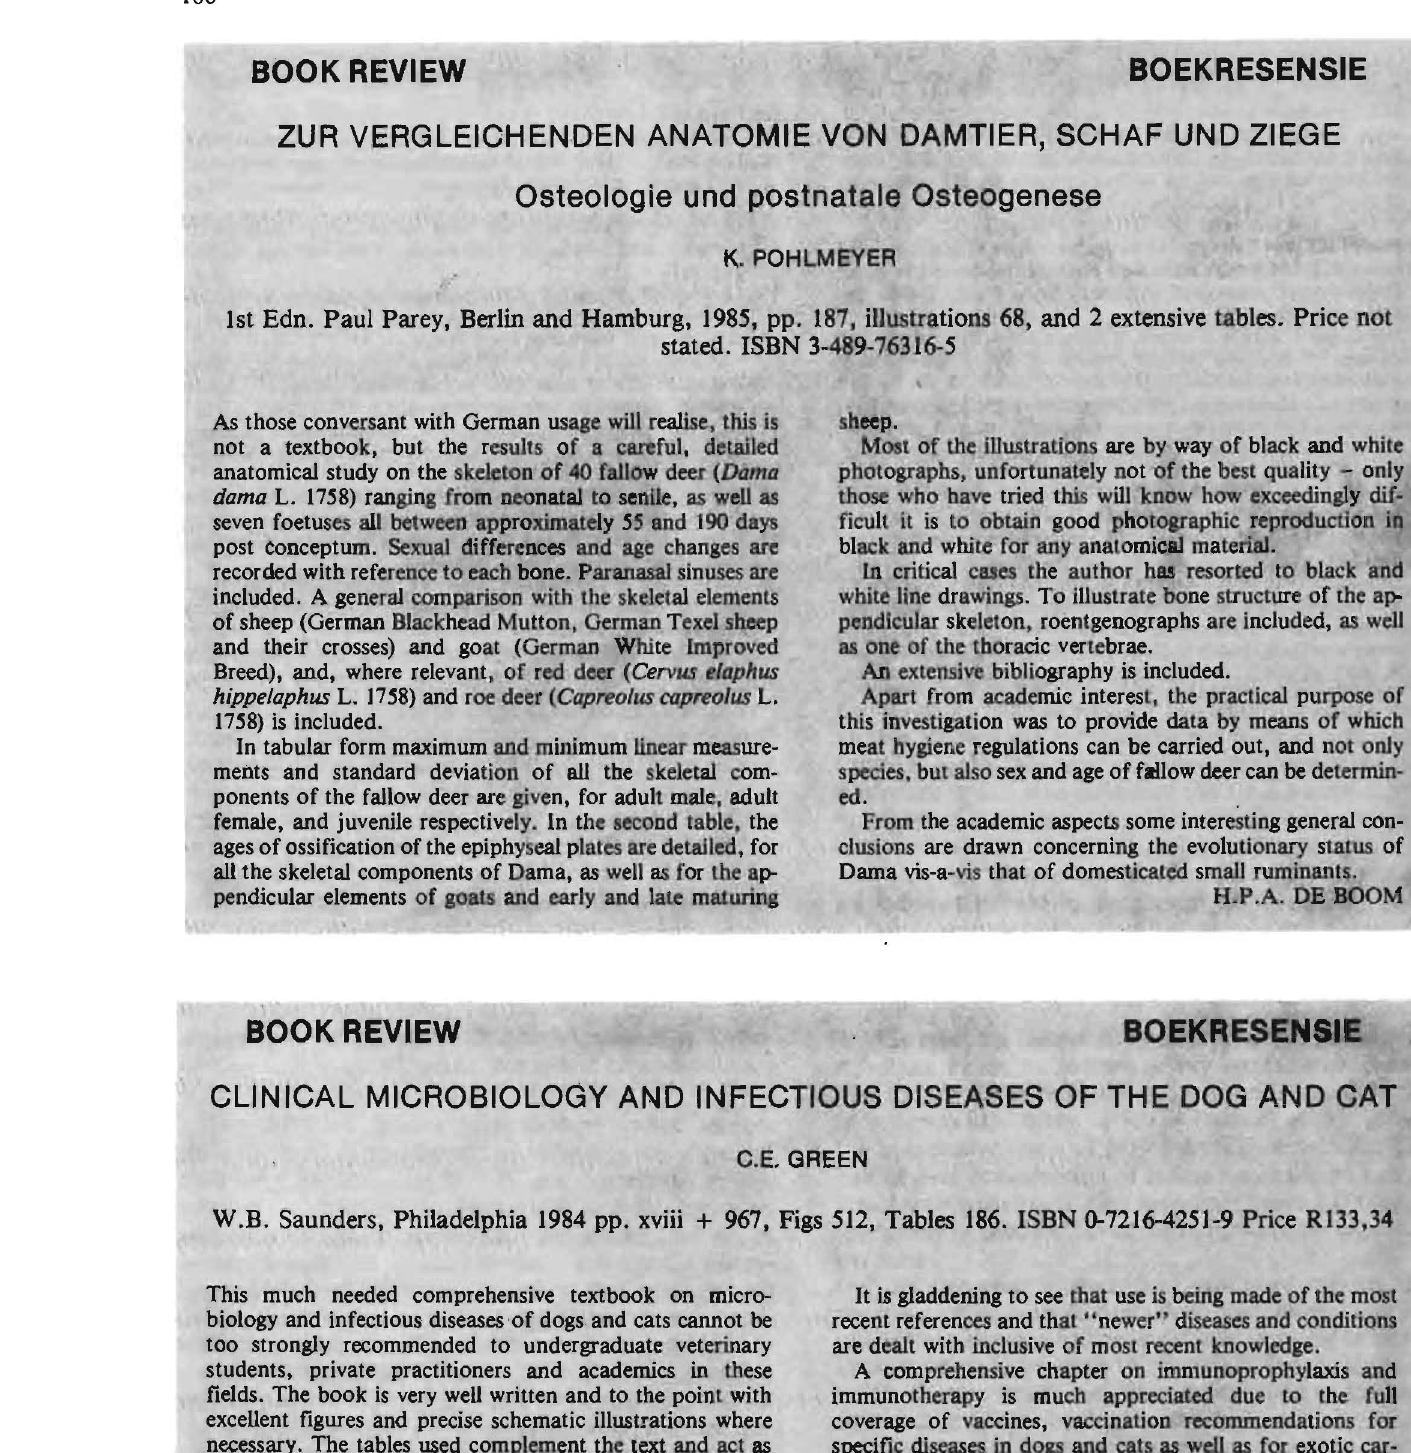
sbeep. Moat of the iUwtrations are by way of black and